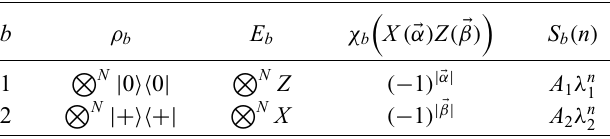
TABLE I. The initial states, measurements, weighting, and fit- ting functions for CX -dihedral-bias RB. Here, |(cid:3) α | denotes the Z (cid:3) α and similarly for | (cid:3) β | 2 -valued sum of all elements of